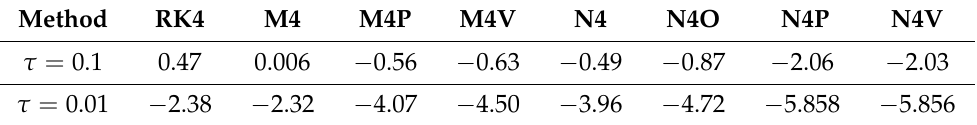
Table 2. Position errors for the algorithms in Figure 1b,d.